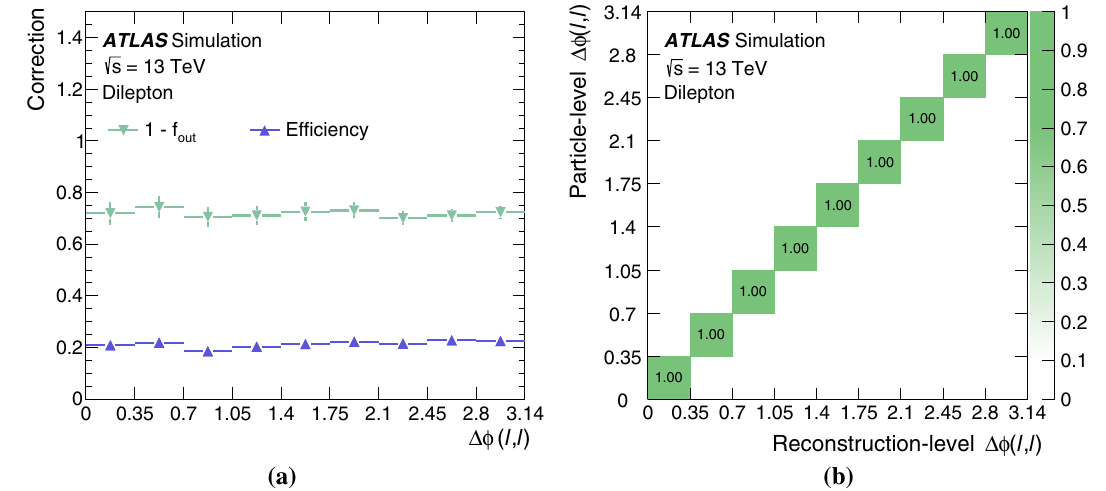
Fig. 17 The a efficiency and outside fraction and b migration matrix for the dilepton azimuthal angle in the dilepton